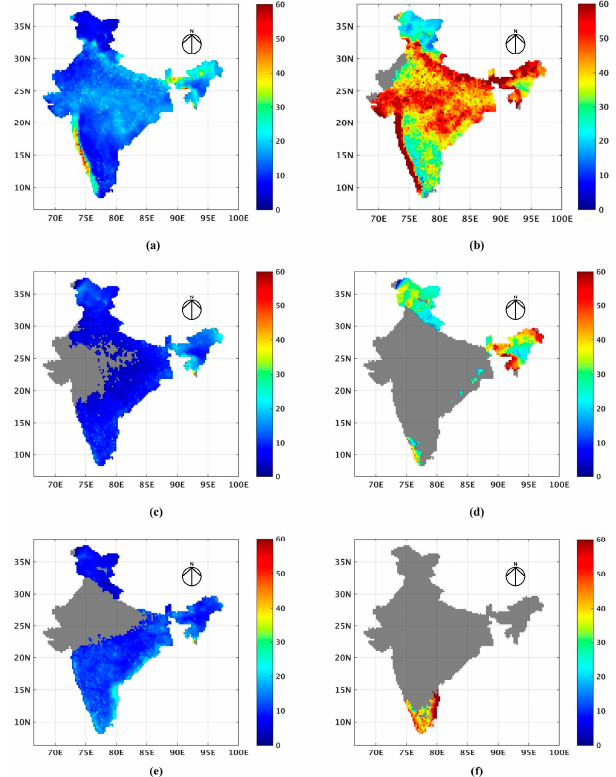
Figure 7. Spatial distribution of higher quantile rainfall intensities over India using IMD precipitation data from 1979 to 2013: ( a ) JJAS (Q > 75); ( b ) JJAS (Q > 95); ( c ) MAM (Q > 75); ( d ) MAM (Q > 95); ( e ) ON (Q > 75); ( f ) ON (Q > 95).